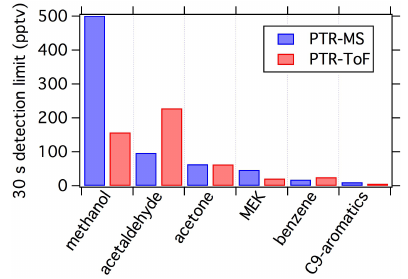
Figure 6. PTR-QMS and PTR-TOF 30s detection limits during